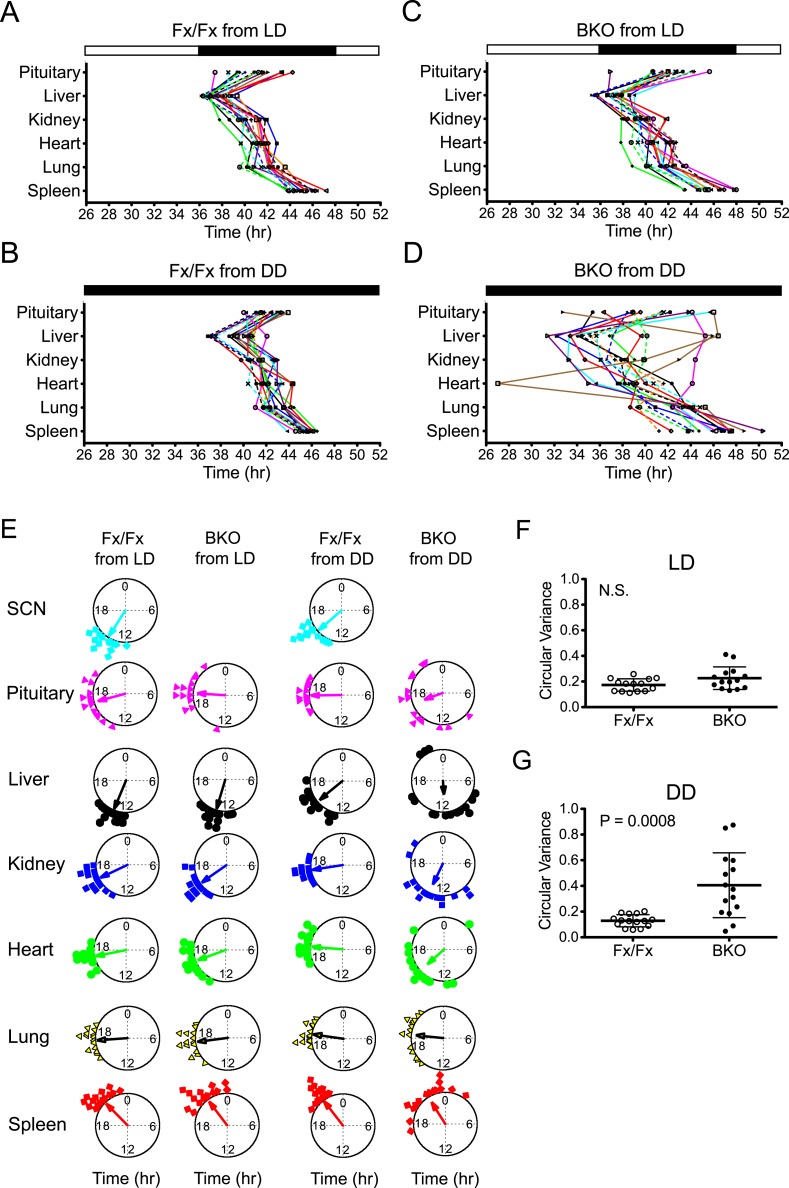
Phase analysis of circadian expression of various peripheral tissues from the forebrain/SCN knockout mice.(A) Phase map of circadian rhythms of various peripheral tissues from Fx/Fx control mice in LD (n = 15, except for pituitary n = 14). The peak phases (or averaged peak phases where more than two pieces were prepared from the same tissue) in the second cycle were plotted against the LD cycle of the day when explant cultures were prepared. Tissues from the same animal are connected by colored lines with matched symbols. (B) Phase map of Fx/Fx control mice in DD (n = 15). The peak phases (or averaged peak phases) in the second cycle were plotted against the predicted onset of activity (=CT12) of the day when the explant cultures were prepared. (C) Phase map of BKOs in LD (n = 15, except for pituitary n = 14). (D) Phase map of BKOs in DD (n = 15). The phases were mapped against the predicted onset of activity (= CT12) of paired Fx/Fx control mice. (E) Circular plots of peak bioluminescence rhythms in the SCN and peripheral tissues presented in (A–D). A circle represents a 24-hr clock, and peak phases of bioluminescence rhythms of individual tissues were calculated as angles and plotted as colored symbols outside the circle. Each tissue is denoted by the same color and symbol scheme. The direction of the arrow indicates mean phase angle, with the length of the arrow expressing the strength of phase clustering. The sample size, mean phase angle, and circular variance for each dataset are summarized in Figure 5—source data 1A. (F, G) Scattered plot of circular variance in each individual mouse. Degree of variance among the peak phase values of pituitary, liver, kidney, heart, lung, and spleen in each individual mouse was calculated and expressed as circular variance (see Figure 5—source data 1B,C) and compared between Fx/Fx controls and BKOs in LD (F) and DD (G). The bar is ±SD. A significant effect was found between Fx/Fx control and BKO mice in DD (p = 0.0008 by Mann–Whitney test) but not in LD (p = 0.0627 by Mann–Whitney test). N.S. = not significant.DOI:
http://dx.doi.org/10.7554/eLife.04617.01010.7554/eLife.04617.011Figure 5—source data 1.(A) Summary of statistical analysis of circular plots presented in Figure 5. (B) Statistical analysis of circular variance for peak bioluminescence in individual mice in LD. (C) Statistical analysis of circular variance for peak bioluminescence in individual mice in DD.